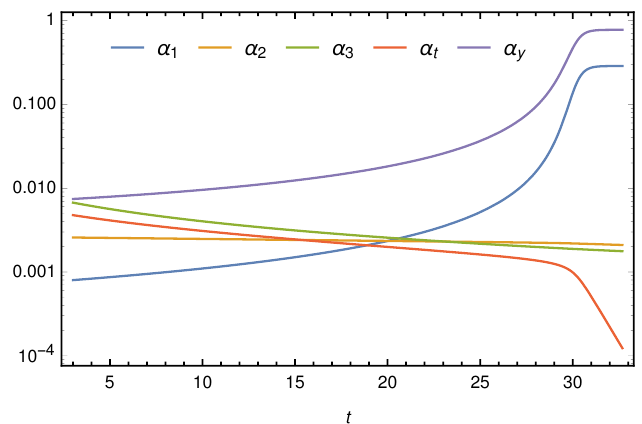
Figure 7 . Evolution of the couplings with t in a logarithmic scale for the (cid:12)xed point in table 8). This running provides a trajectory in the theory space connecting the (cid:12)xed point and the physics at a matching scale around 2